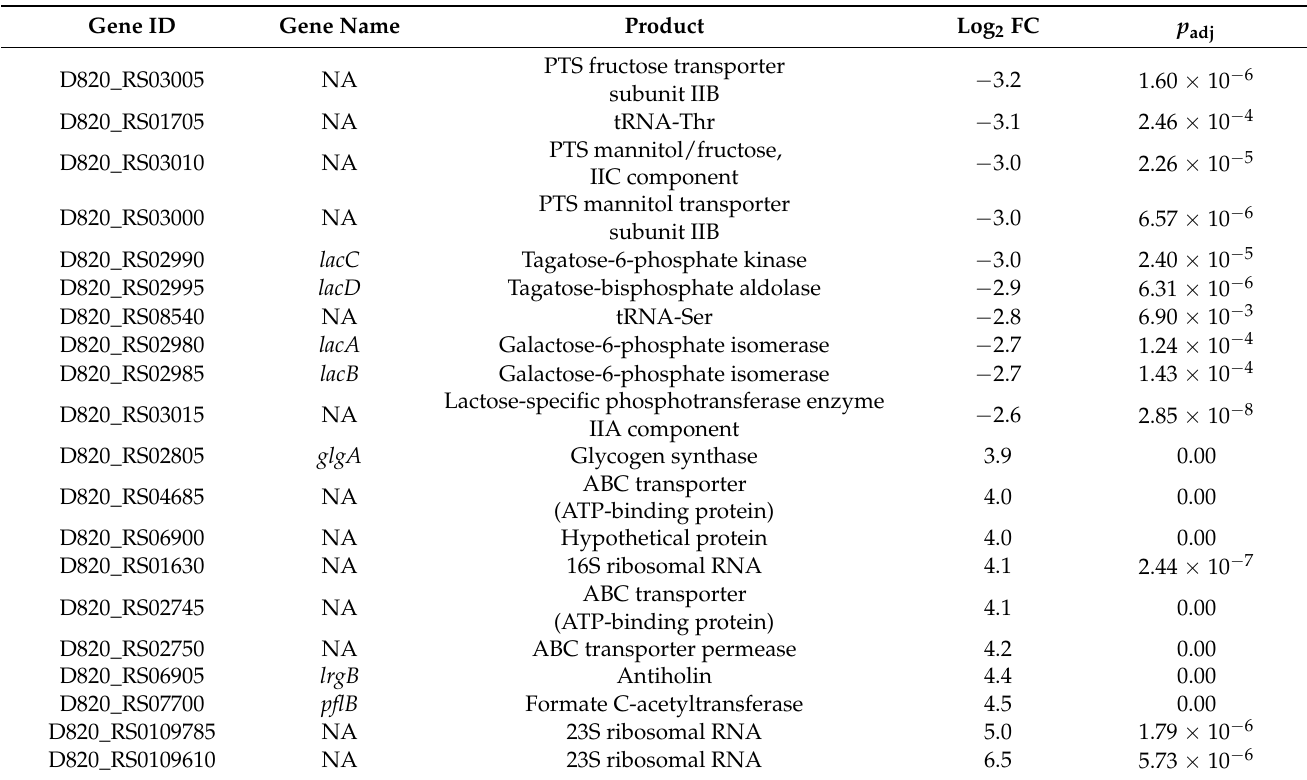
Table 2. The 10 most up- and downregulated genes in S. mutans upon sublethal CHX treatment. The full list of DE genes can be found in the Supplemental Table S1.